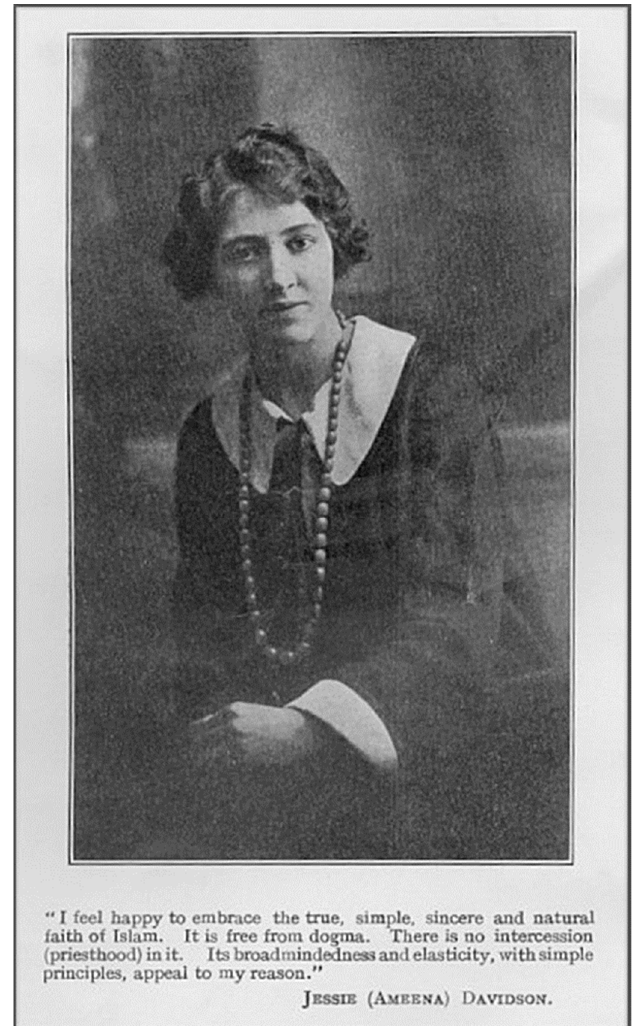
Figure 2. This is a photograph of Jessie Ameena Davidson. Image courtesy www.wokingmuslim.org